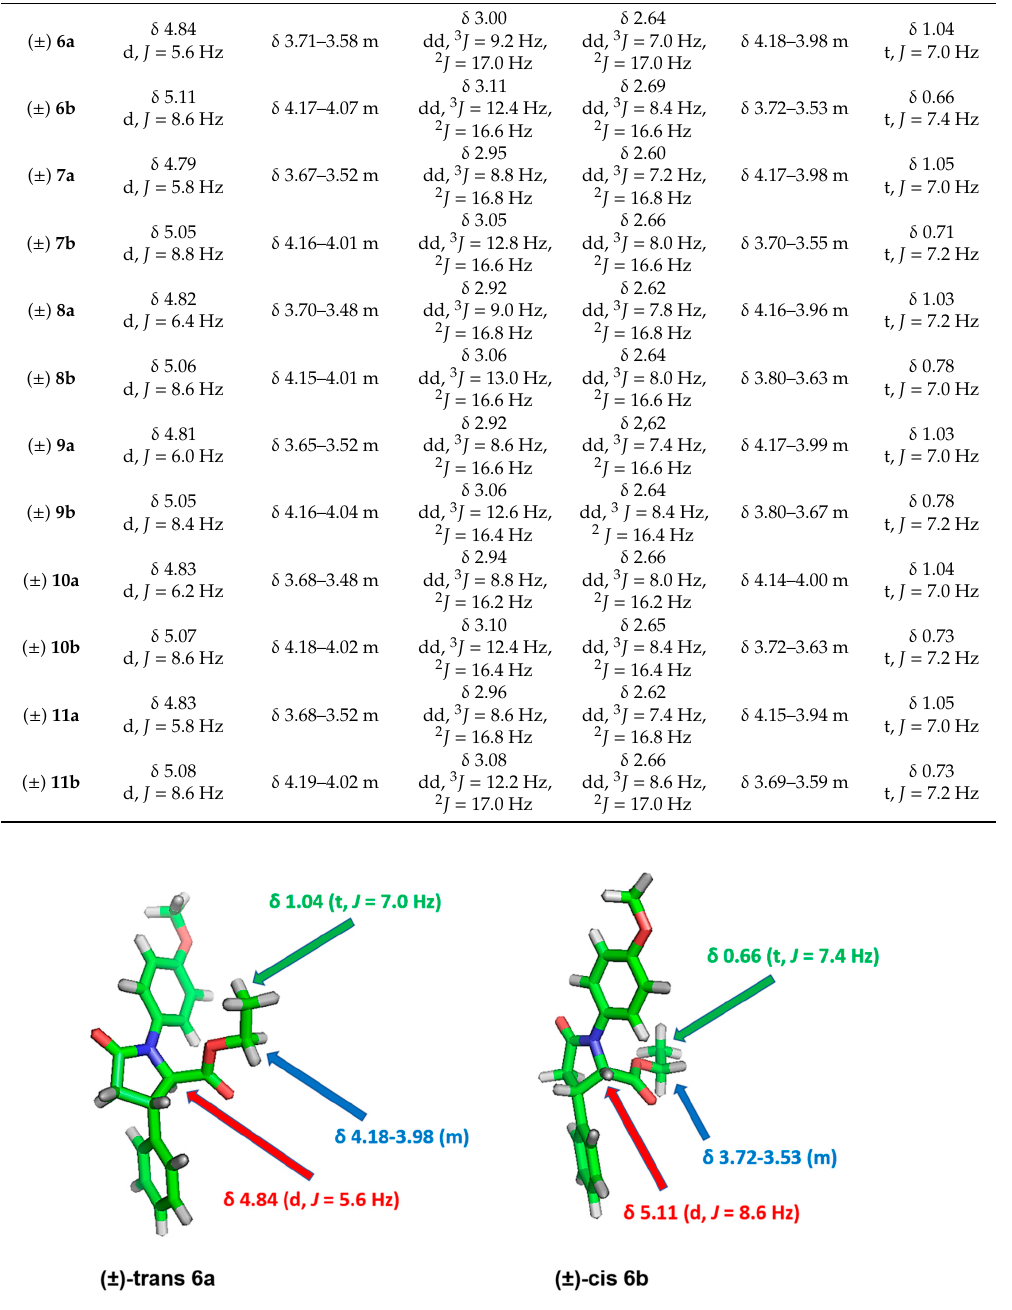
Figure 3. The 1 H NMR signal attribution for the selected compounds (±)- trans 6a and (±)- cis 6b